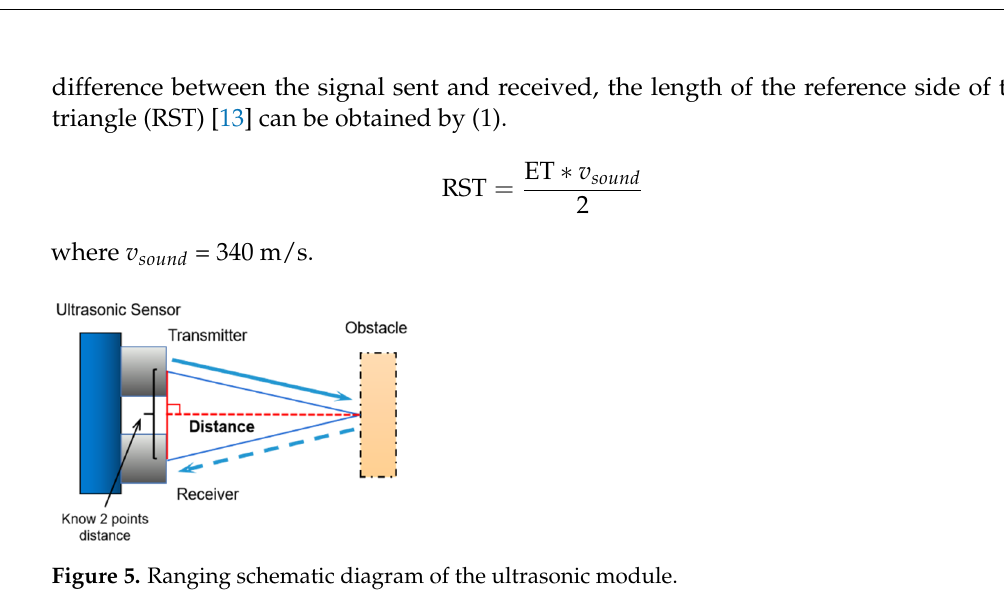
Figure 4. Schematic diagram of the system workflow.